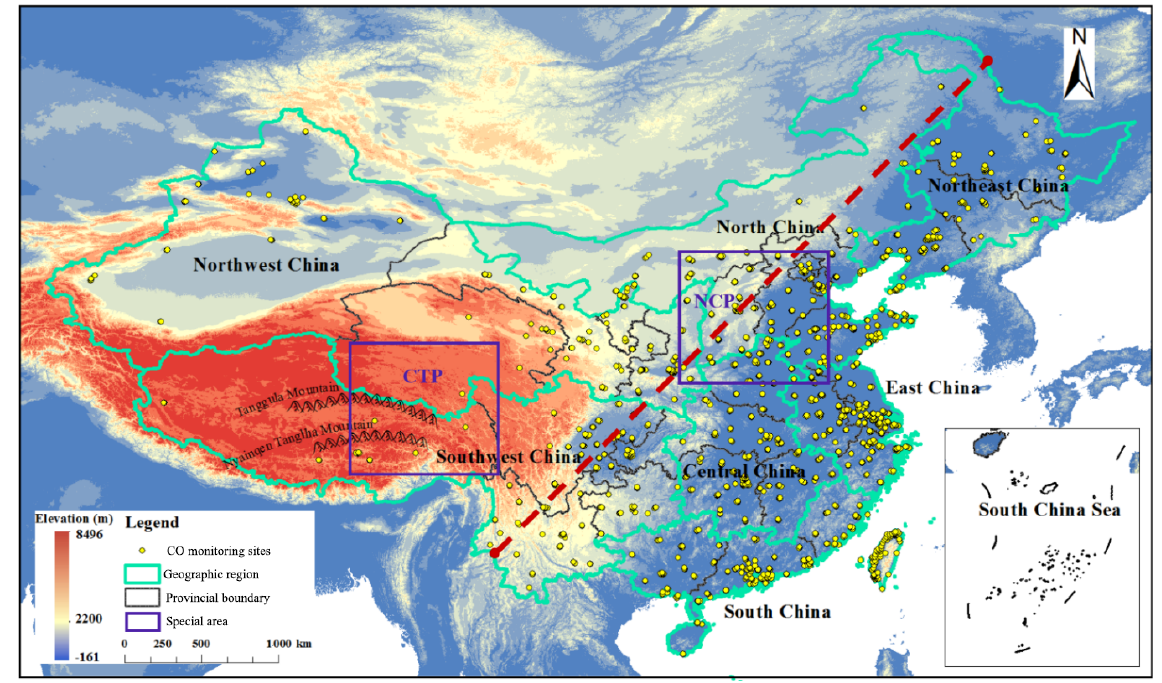
Figure 1. Ground-level CO monitoring network for China in 2013–2016 with 1656 sites in total. The central Tibetan Plateau (CTP) and the North China Plain (NCP) are labeled on the map. The red dashed line represents the Heihe–Tengchong Line, which is an imagined “geo-demographic demarcation line” reflecting the disparity in the population distribution. Around 95% of the population live to the east of the line, where 82% of the monitoring sites are